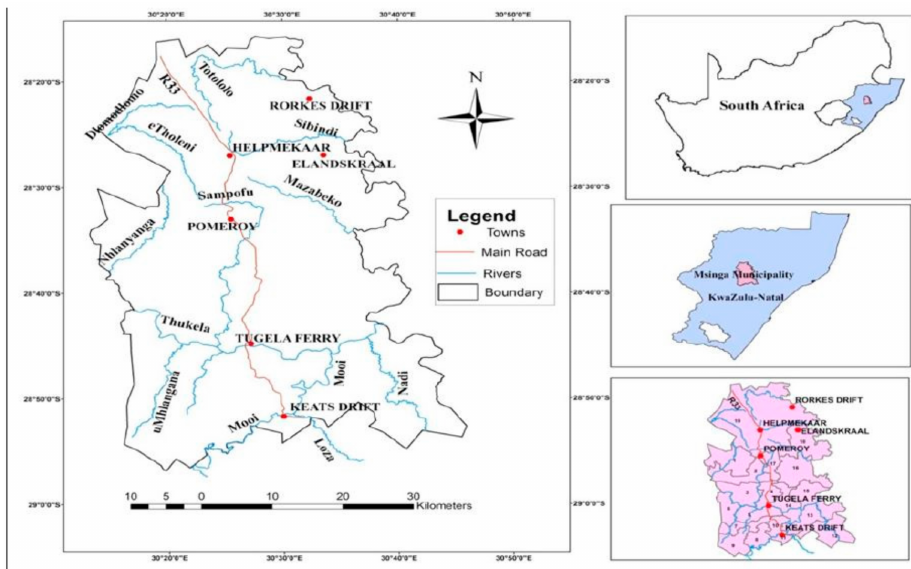
Figure 1. The Tugela Ferry and Mooi River Irrigation Schemes in Msinga Local Municipality, South Africa. Source